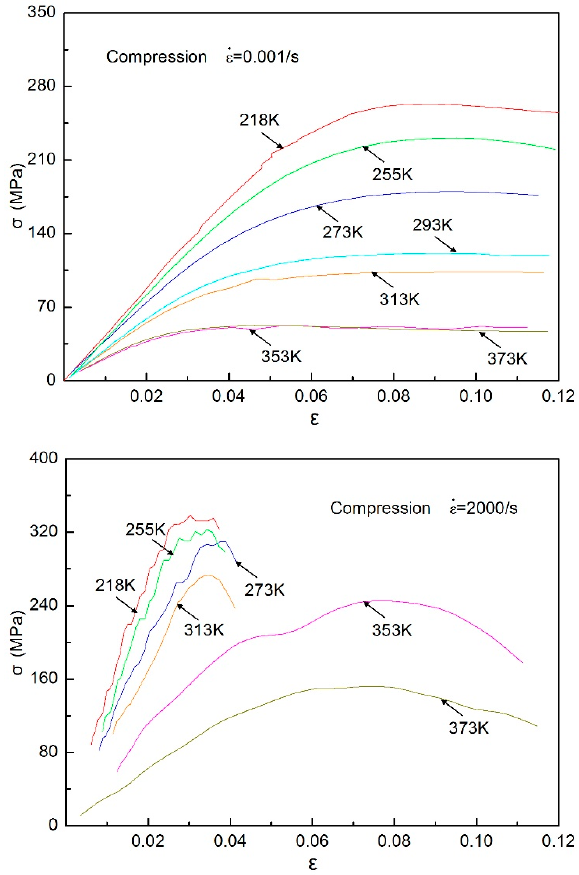
Figure 12. Quasi-static and dynamic compressive stress–strain curves of directional polymethylmethacrylate at different temperatures.